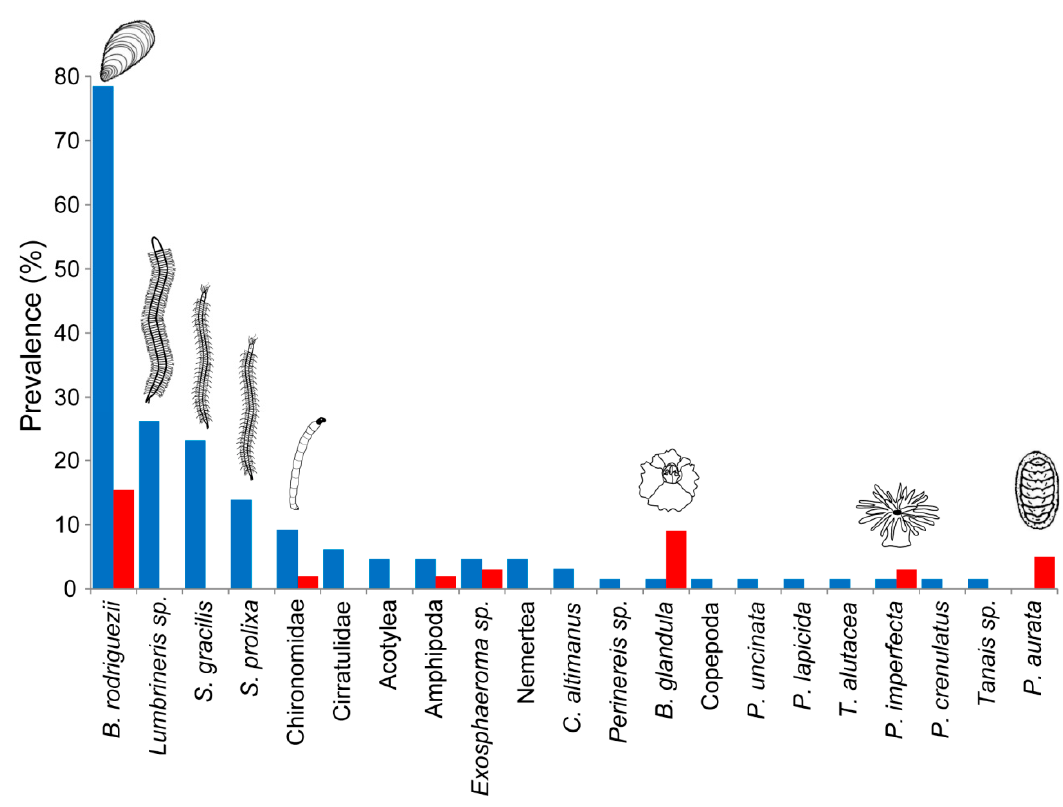
Figure 2. ( a ) Species accumulation curves (continuous lines) for Petricola -engineered (blue) and unengineered (red) patches at the lower platform with their respective 95% confidence intervals (dashed lines). The observed species richness ( S obs) for 65 samples is shown for both habitats together with the values of the Chao 2 estimate of total species richness (blue and red circles for Petricola -engineered and unengineered patches, respectively). ( b ) Species accumulation curves and their confidence intervals for species present inside Petricola boreholes in engineered patches (blue) and on the rock surface in unengineered patches (red) in relation to the rock surface area. The curve for boreholes extends further than that of unengineered rock surfaces because of differences in surface area sampled (boreholes = 0.76 m − 2 , unengineered rock surface = 0.65 m − 2 ).